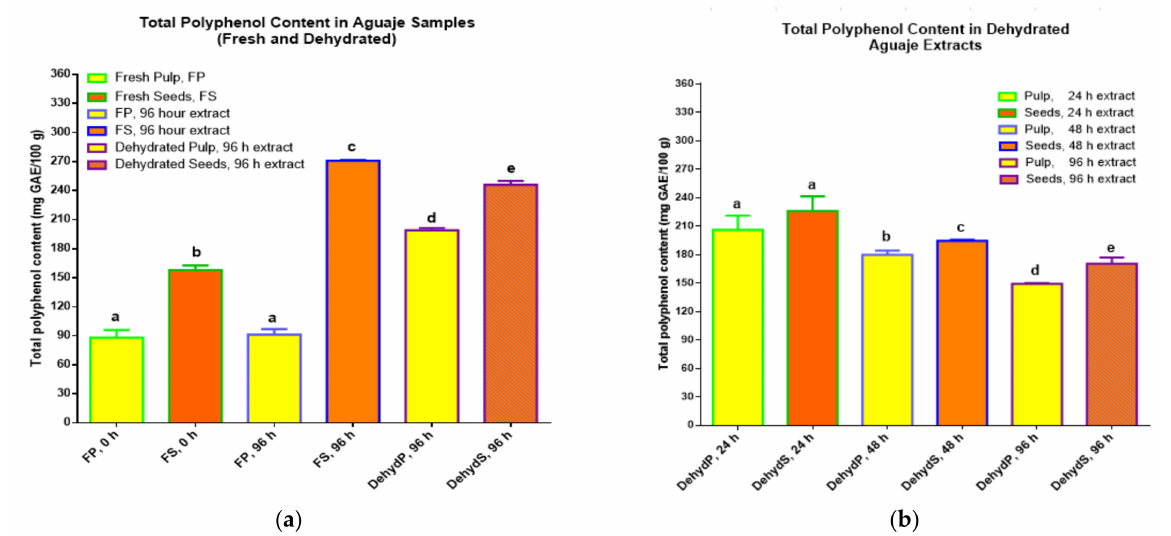
Figure 3. TPC (mg of gallic acid equivalents per 100 g) of fresh and dehydrated pulp and seeds of ( a ) M. flexuosa (aguaje) fresh and dehydrated pulp and seeds for the initial experimental assay and ( b ) TPC in M. flexuosa dehydrated pulp and seeds in a second assay. Data are means ( ± standard deviation), and lower-case letters represent significant differences, for total polyphenol content in mg GAE/100 g of initial sample, based on ANOVA followed by Tukey test ( p <